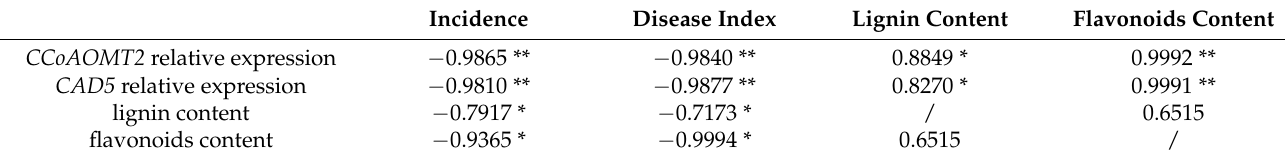
Table 4. Correlation analysis of gene expression, incidence, disease index and lignin content.